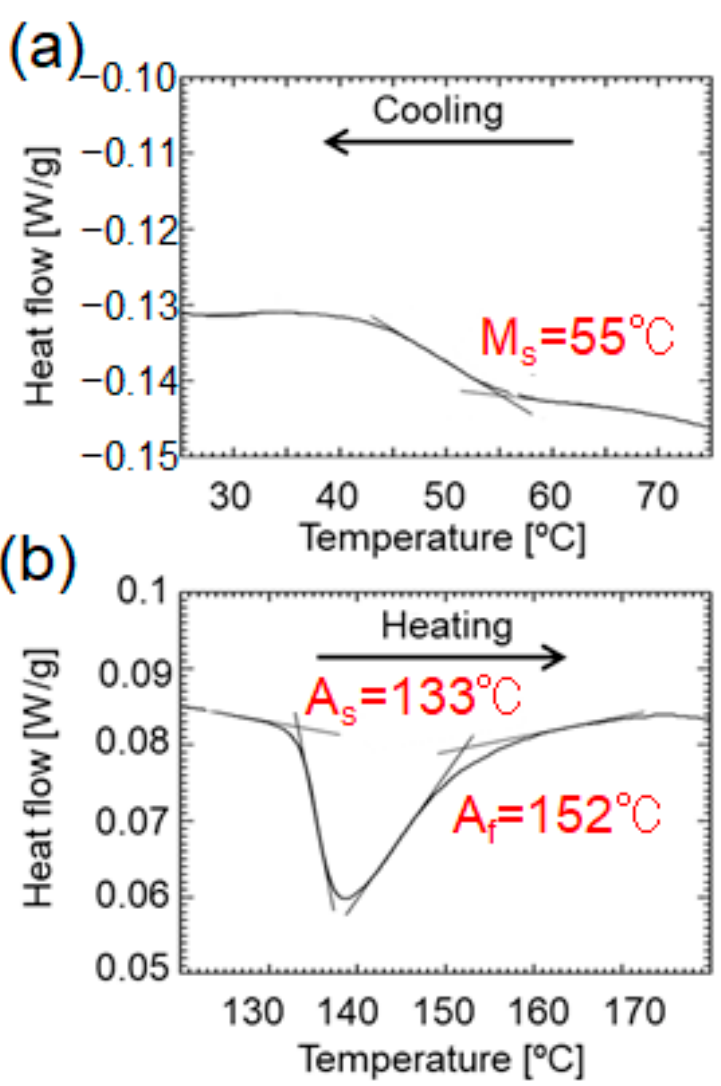
Figure 2. DSC curves of ( a ) cooling and ( b ) heating processes.